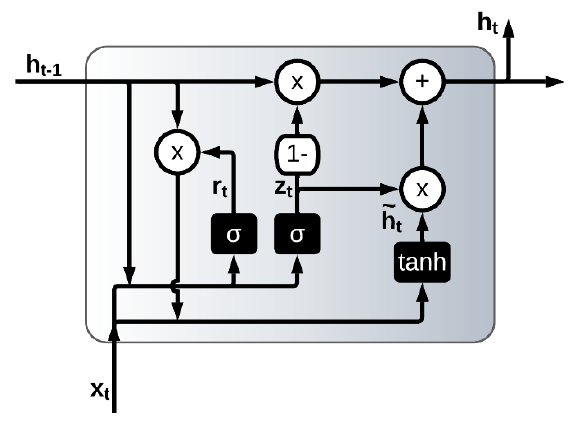
Figure 1. The architecture of the proposed GRU